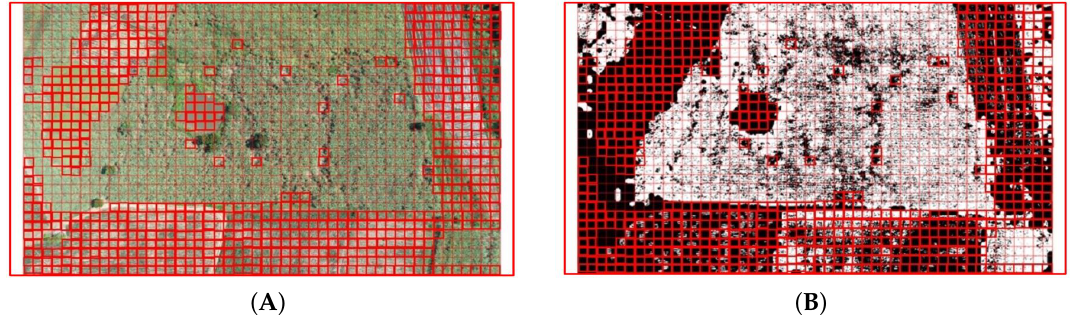
Figure 14. Comparison results between experts and the defect defection model. ( A ) The results of the expert and ( B ) the results of the defect defection